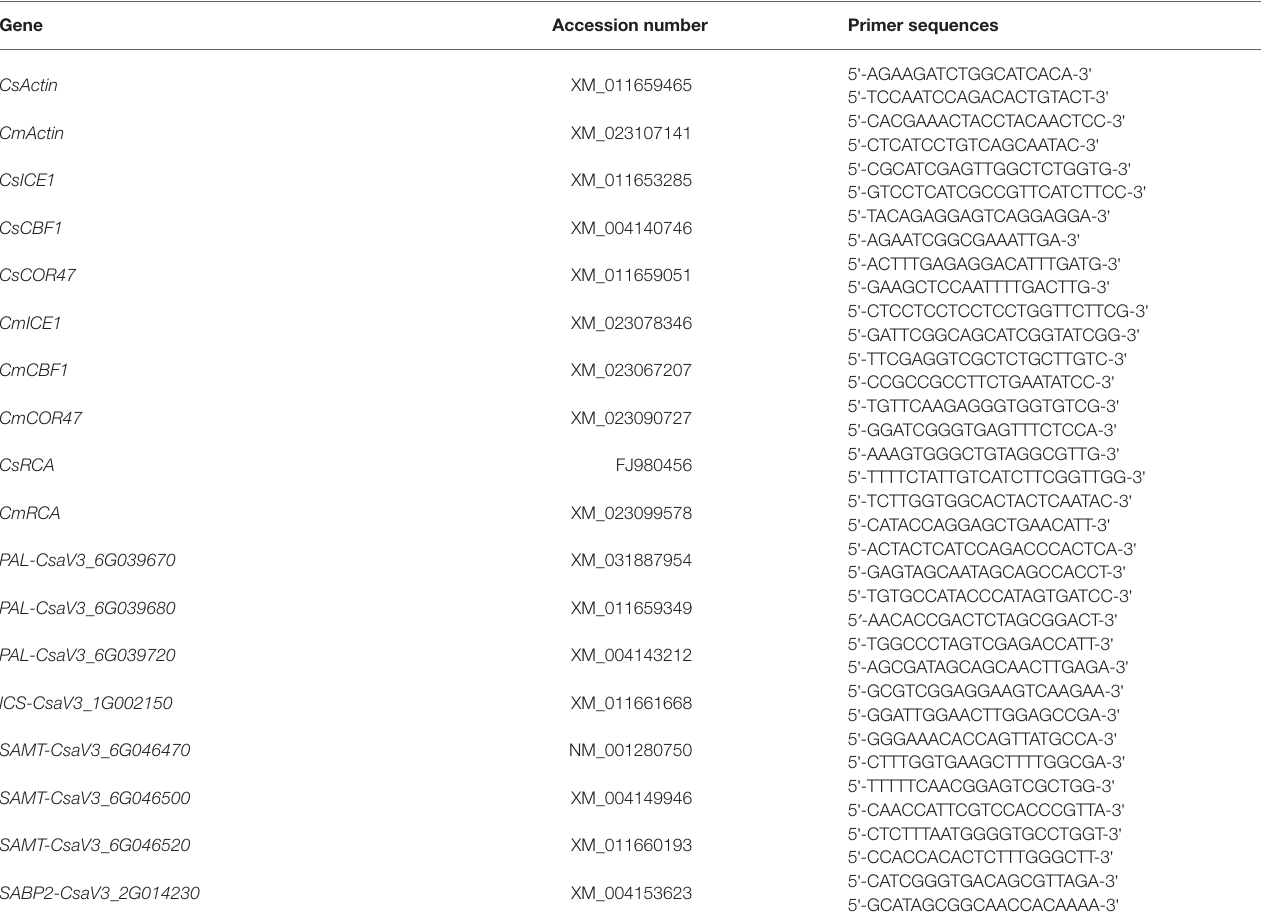
TABLE 2 | Primer sequences.